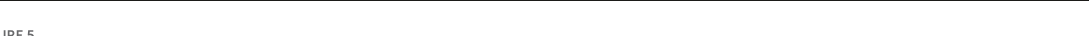
FIGURE5 91.49% of all genera present. Genera are listed from the less abundant to the more abundant within each phylum, and ordered in ascending order (Spirochetes, Actinobacteria, Fusobacteria, Proteobacteria, Bacteroidetes, and Firmicutes). Color bars reflect the phyla they belong to and the intensity of the color their relative abundance, with light colors depicting the least abundant, and the darker colors the more abundant. HIV, human immunodeficiency virus; LATP, left anterior tonsillar pillar; PCoA, principal coordinate analysis; PERMANOVA, permutational multivariate analysis of variance; OR, oral rinse; PLWH, people living with HIV; SN, seronegative; RATP, right anterior tonsillar pillar; TF-L, tonsillar-fossa left; and TF-R, tonsillar